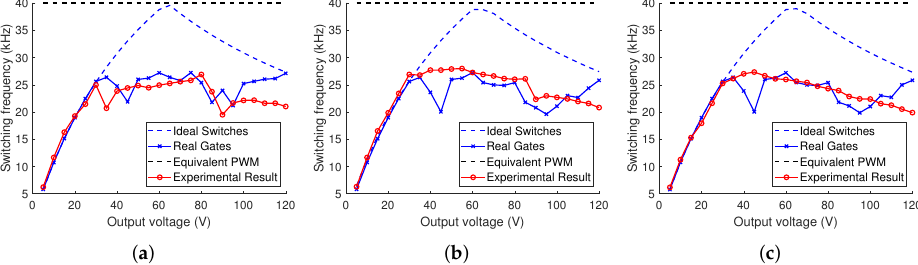
Figure 5. Switching frequency variation with min-type controllers ( a ) Quadratic Non-Sampled (QNS) Controller, ( b ) Robust Non-Sampled (RNS) Controller, ( c ) Robust Sampled